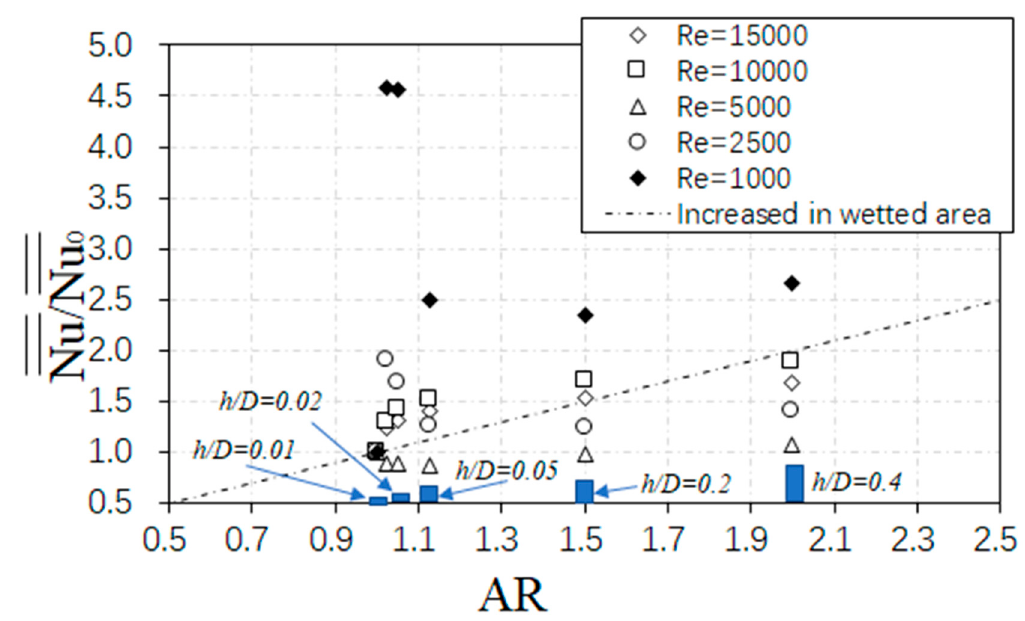
Figure 20. Spatially averaged Nusselt number ratios as dependent upon wetted area ratio, for different micro cooling units height, and different Re j .